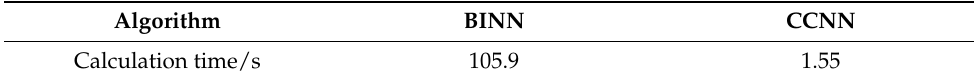
Table 1. Calculation time in different algorithm.